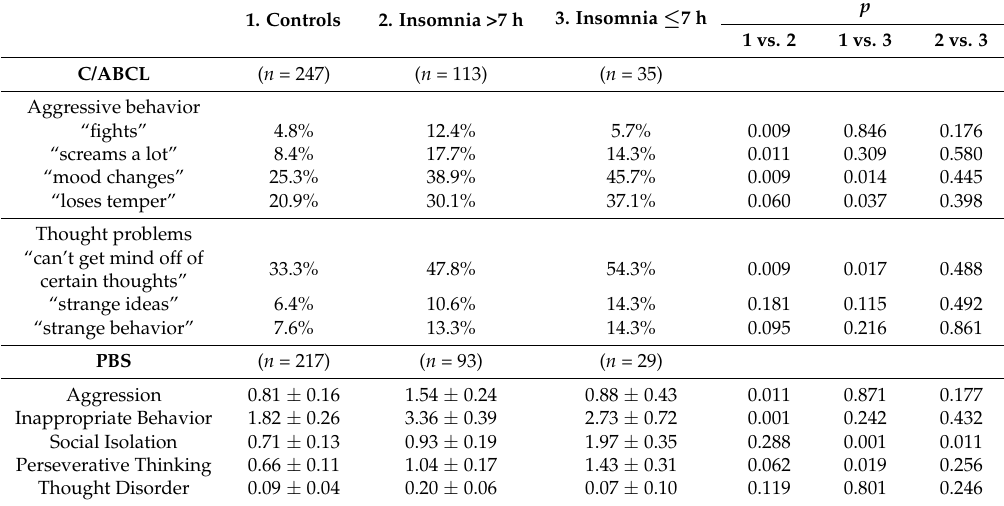
Table 3. Item-level analysis of the Child / Adult Behavior Checklist (C/ABCL) and related subscales of the Pediatric Behavior Scale (PBS) across insomnia symptoms and objective sleep duration subgroups. 1.